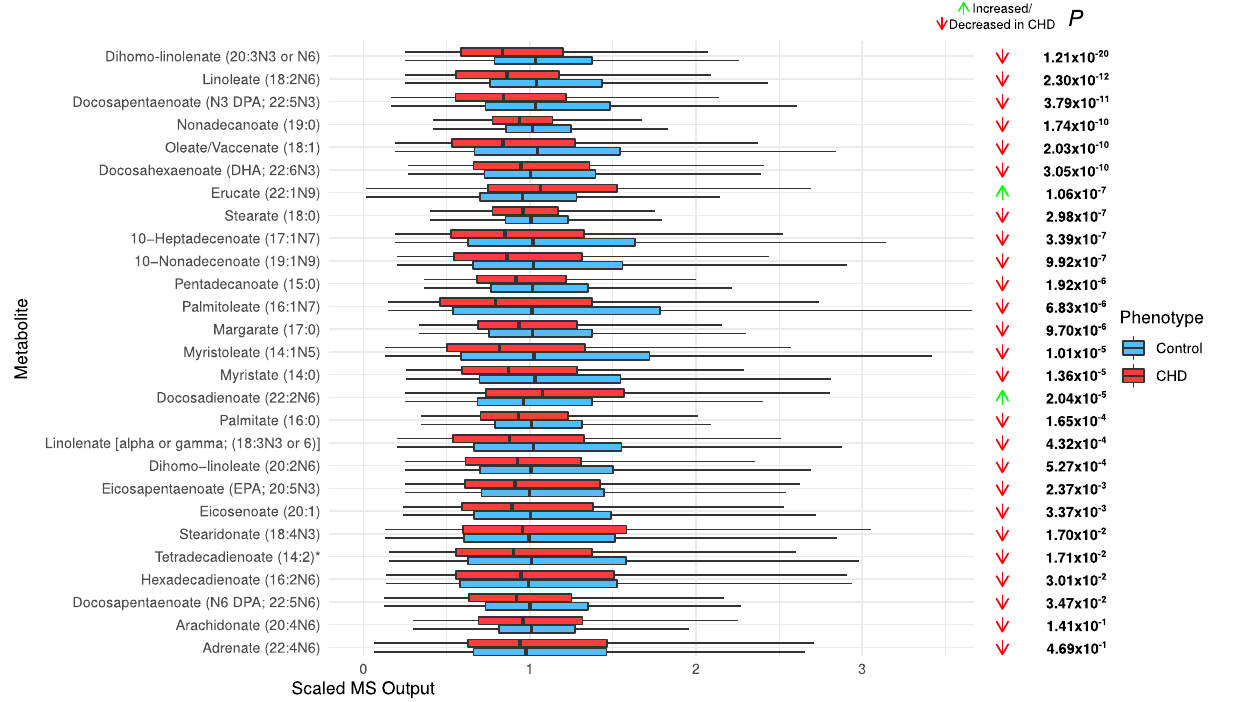
Figure 3. The distribution of significant acylcarnitines in the CHD patients and the controls.